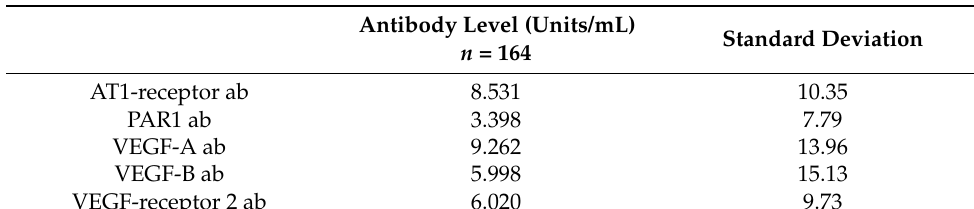
Table 2. Antibody levels in nAMD patients. ab, antibody; AT1, Angiotensin II receptor type 1; PAR1, Protease-activated receptors; VEGF, vascular endothelial growth factor.